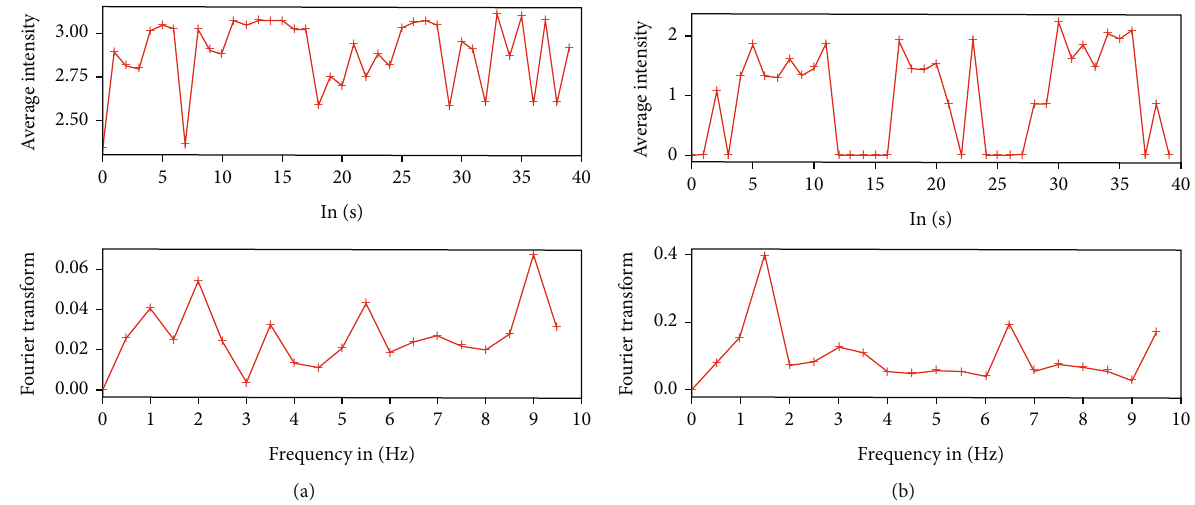
Figure 11: The features of the turn-light signal extracted from APS frames and DVS events in 2s time interval. The top row is the feature of before the transformation. The bottom row is feature after the transformation, and the DC component is set to zero in order to simplify the visualization. (a) The feature extracted from APS frames. (b) The feature extracted from DVS events. Table 3: Turn-light signal measurement